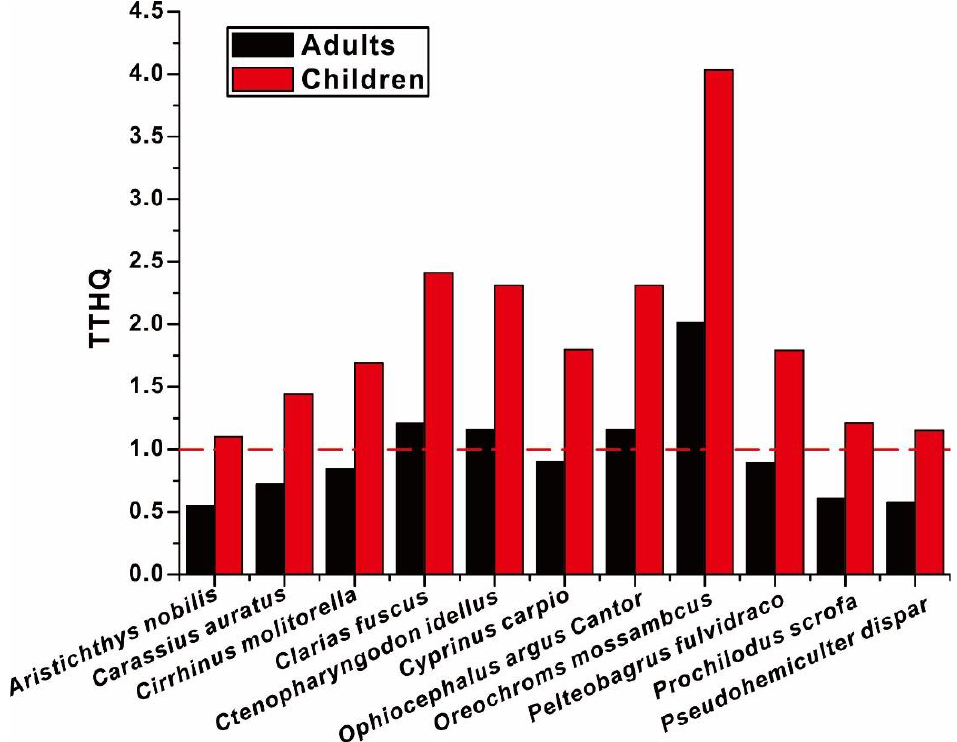
Figure 3. The TTHQ of different fish species for children and